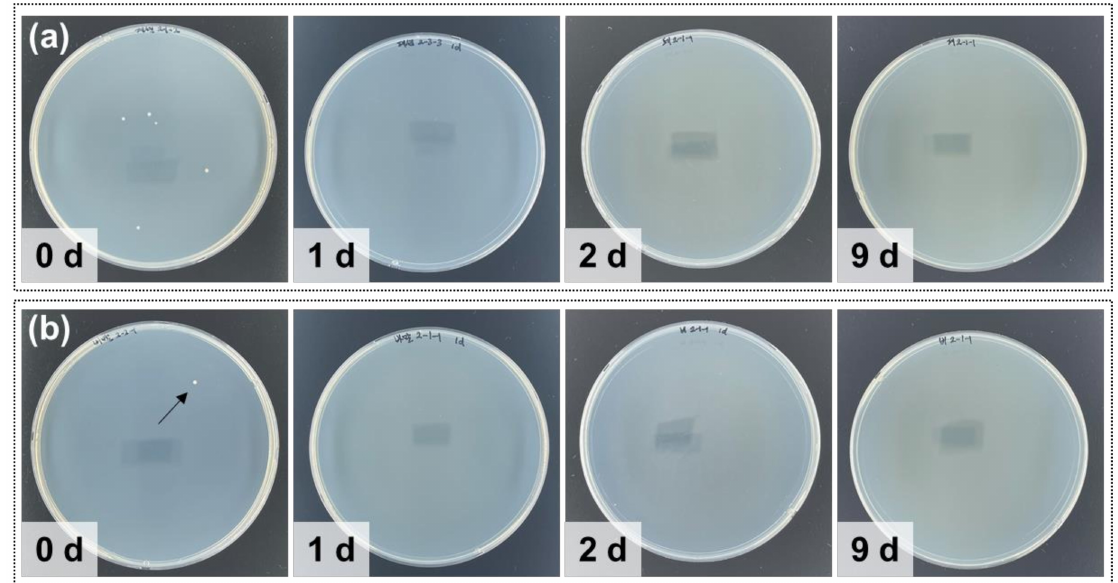
Figure 6. Photographs of airborne B. subtilis bioaerosols grown on agar plates after being derived from ( a ) woven and ( b ) anti-droplet masks that were used as filters of both particulate matters (PMs) and airborne droplets containing bacteria. The arrow marks a colony of airborne B. subtilis cells grown on the